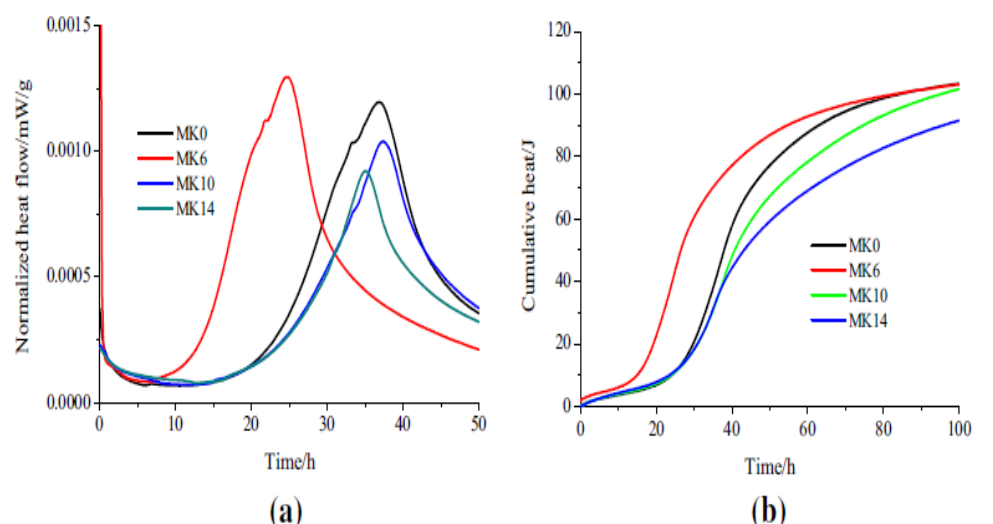
Figure 17. Heat of hydration with MTK ( a ) Normalized and ( b ) Cumulative Heat: Reprinted with permission from [44]